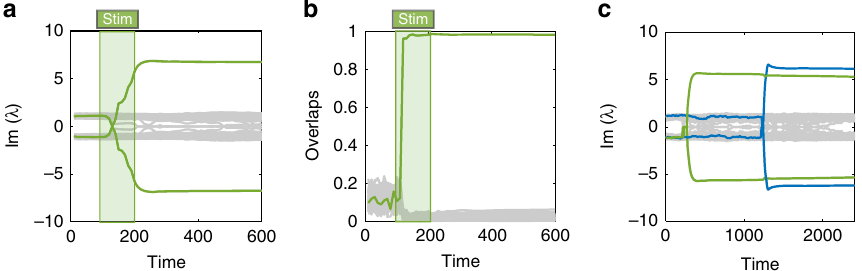
Fig. 3 Hebbian learning by STDP embeds persistent imaginary-coded memory. a Imaginary part of the spectrum of W before, during and after external stimulation (stim.; marked by the shaded green area) applied between times t = 100 and t = 200. Before learning, the imaginary part of the spectrum is almost constant in time. The learning of a memory item manifests as the growth in imaginary amplitude of one complex conjugate eigenvalue pair (green trajectories). b During stimulus presentation, the learning rule modi fi es W such that the plane spanned by u , v is invariant. Plotted are the overlaps of this eigenplane of W , corresponding to the largest imaginary eigenvalue pair, with N /2 planes: the u , v (green), and N /2 − 1 orthogonal planes (gray); see “ Methods ” . c Zoom-out of ( a ). After the stimulus is removed, the memory representation persists (green). A second stimulus, con fi ned to a second plane, is similarly learned at a later time (blue); both memory items are retained. This fi gure shows results for the decorrelation rule ( N = 128, see “ Methods ” ); qualitatively similar results are obtained for rate-control (see Supplementary Fig.